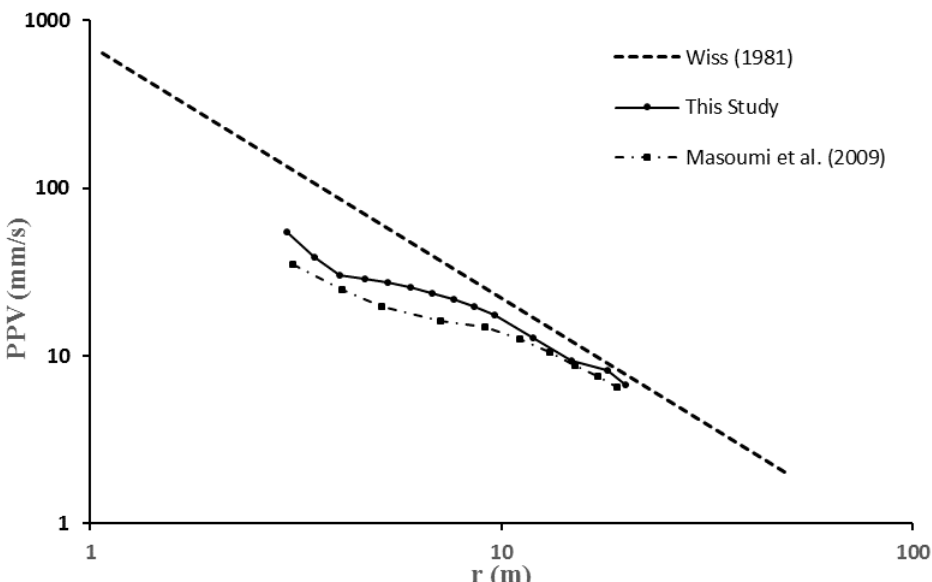
Fig. 5. Comparison of PPV values of this study with experimental results of Wiss (1981) and numerical results of Masoumi et al. (2009) considering maximum PPV at 2, 5 and 10 m embedment